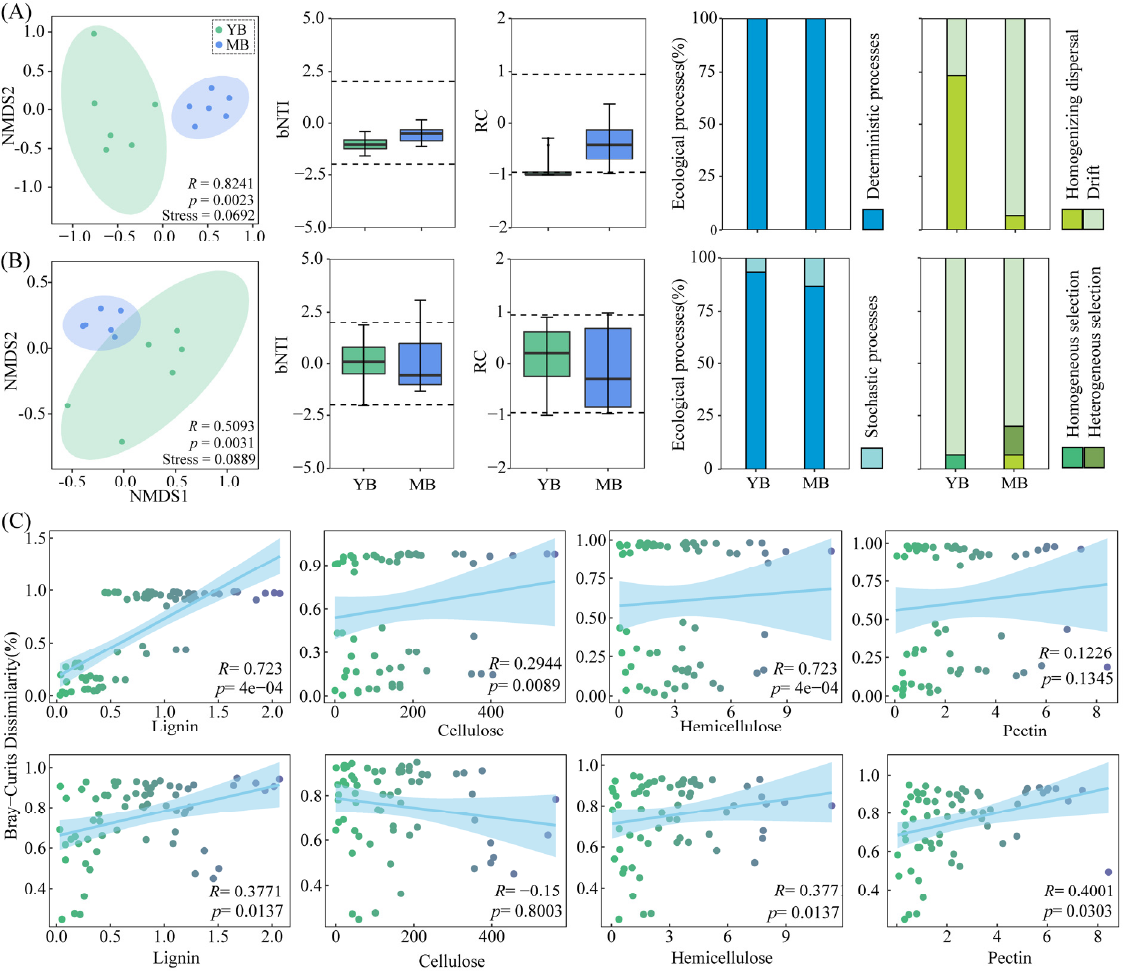
Figure 3. NMDS analysis and non − metric multidimensional scale ordering of endophytic bacterial ( A ) and fungal ( B ) communities, and the relationship between Bray–Curtis dissimilarity with ligni- fication indices ( C ) in young and mature branches of Nitraria tangutorum . YB: young branches; MB: mature branches.